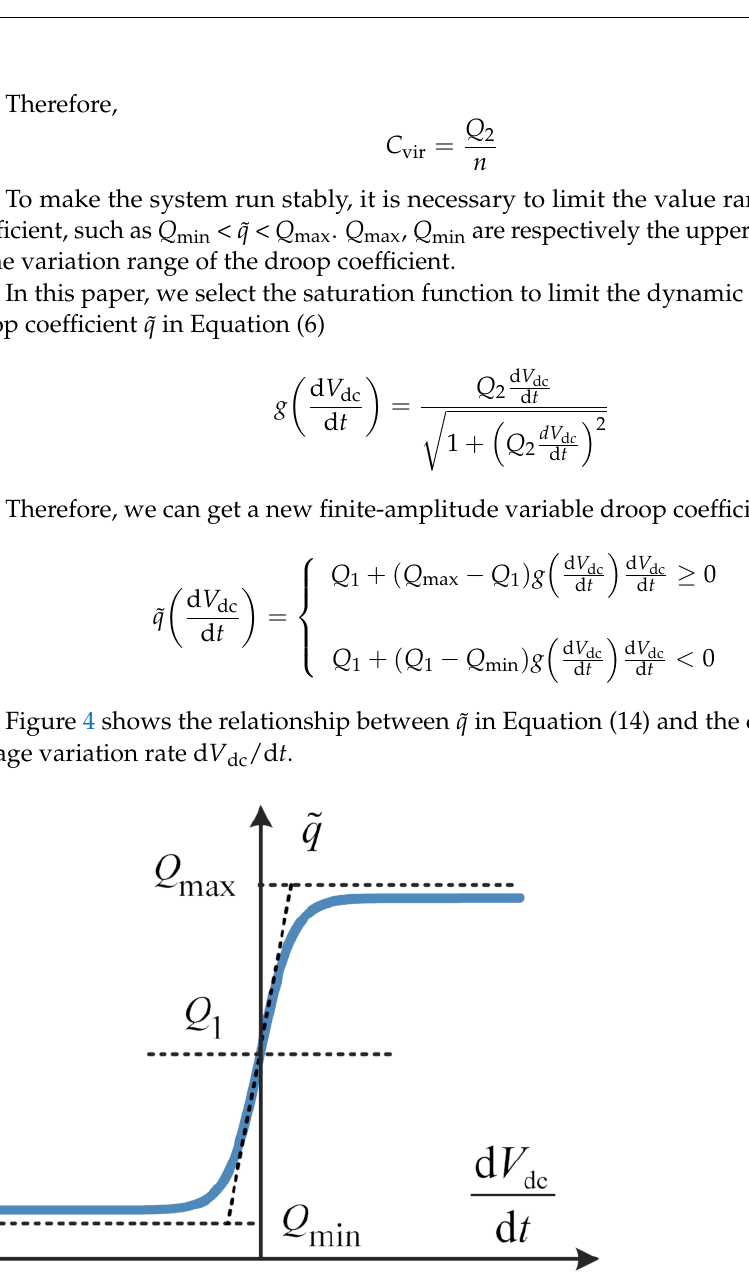
Figure 4. Variation curve of droop